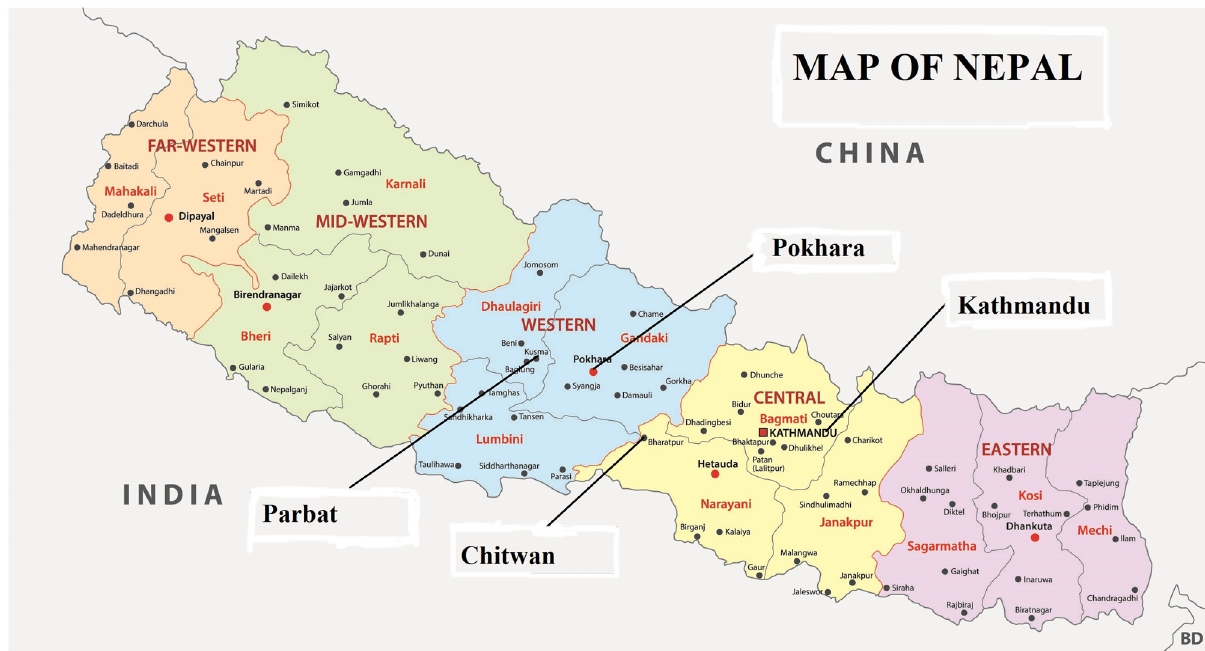
Fig 1. The locations of fields: Kathmandu and Pokhara as urban areasand Parbat and Chitwan as rural areas.